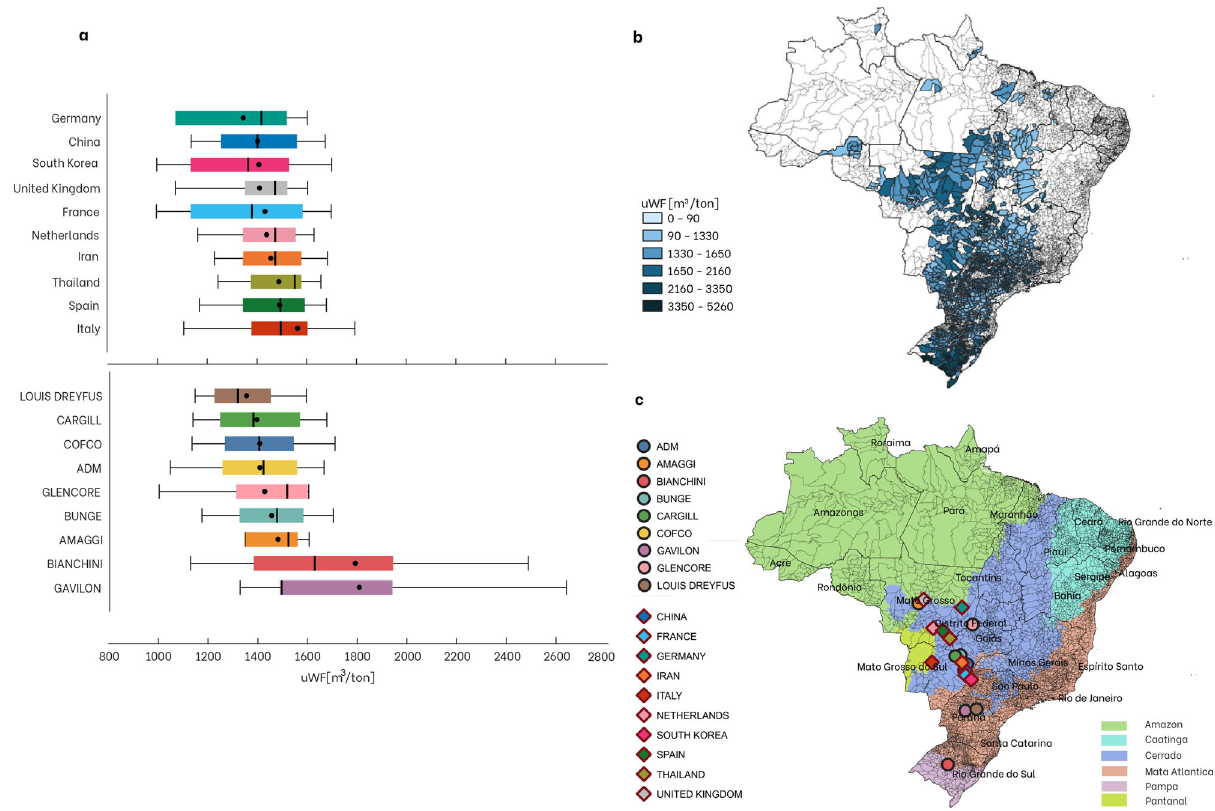
Fig. 2 The different unit water footprint of trading companies and countries. a Boxplots of the unit water footprint (uWF, m 3 /ton) of soybean production for the top-ten importers in 2018 and the top-nine dominant trading companies. The left and the right whiskers refer to 10th- and 90th-percentile, respectively, while the dot represents the average uWF. b Sub-national uWF of soybean in the active exporting municipalities in 2018. c Virtual water- weighted barycenters of countries' and trading companies' virtual water trade over the Brazilian biomes in